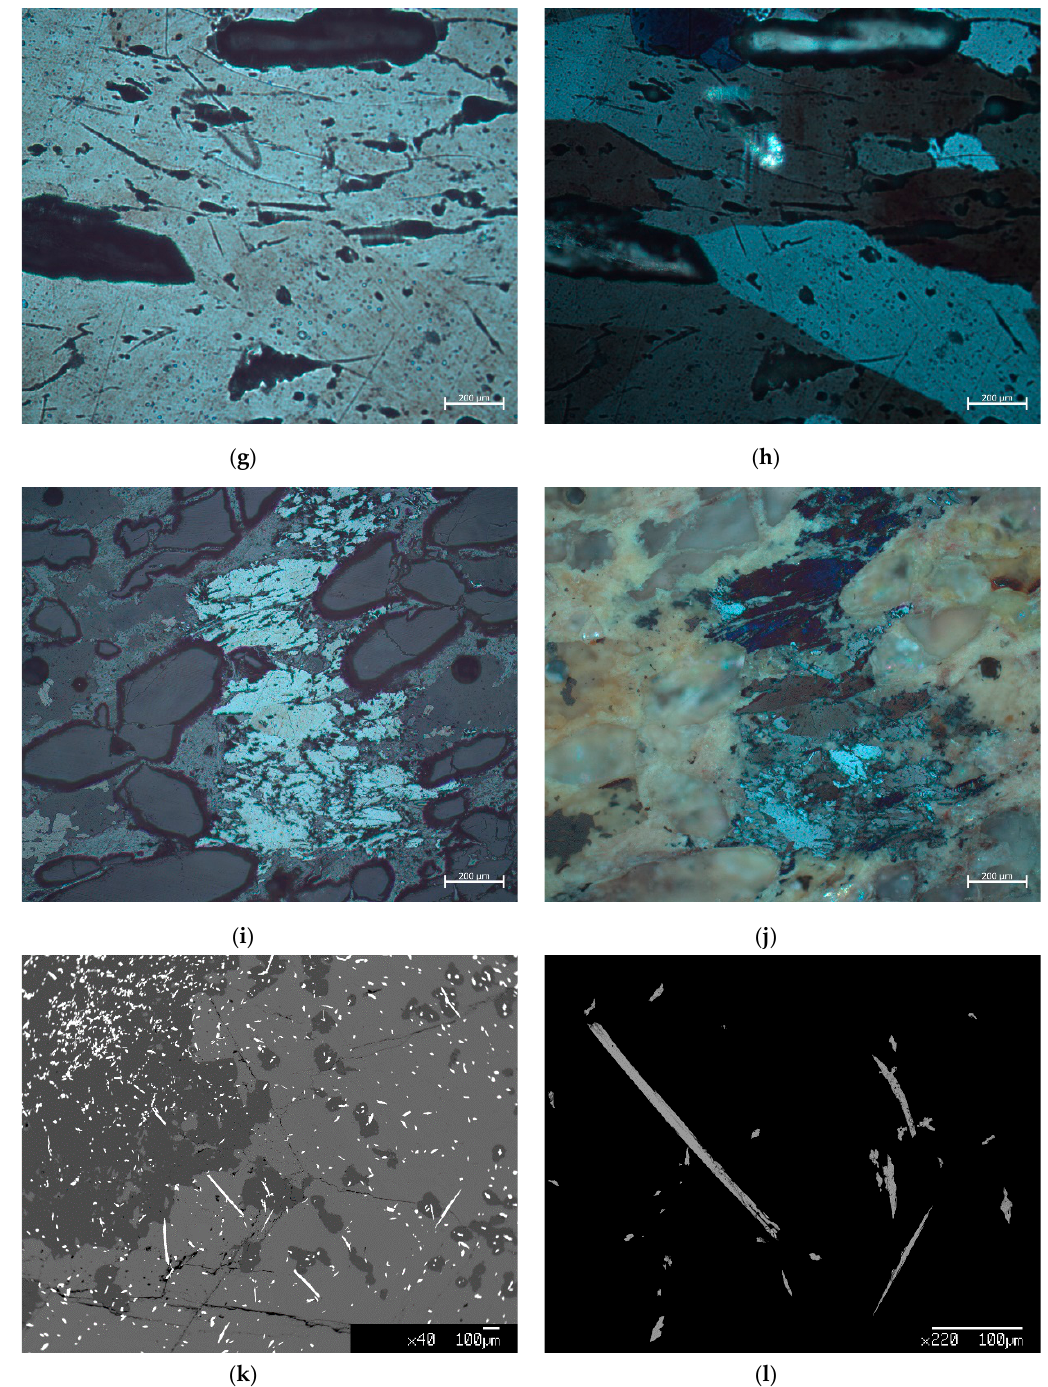
Figure 4. Optical microscopic (reflected light) and SEM images of typical Sb-minerals from Greek Sb ores. ( a ) Stibnite from Stratoni/Mantem Lakkos locality, Nicols; ( b ) Stibnite from Stratoni/Mantem Lakkos locality, Nicols +; ( c ) Boulangerite (Boul) with galena (Ga) from Stratoni/Mantem Lakkos locality, Nicols; ( d ) Boulangerite (Boul) with pyrite (Py) from Stratoni/Mantem Lakkos locality, Nicols; ( e ) Boulangerite from Olympiada locality, Nicols; ( f ) backscattered electron (BSE) image from Olympiada locality; ( g ) Stibnite from Chios island, Nicols; ( h ) Stibnite from Chios island, Nicols +; ( i ) Stibnite from Chios island, Nicols; ( j ) Stibnite from Chios island, Nicols +; ( k ) BSE image of boulangerite (white “needles”) from Kilkis; and ( l ) (BSE) image of boulangerite from Kilkis.